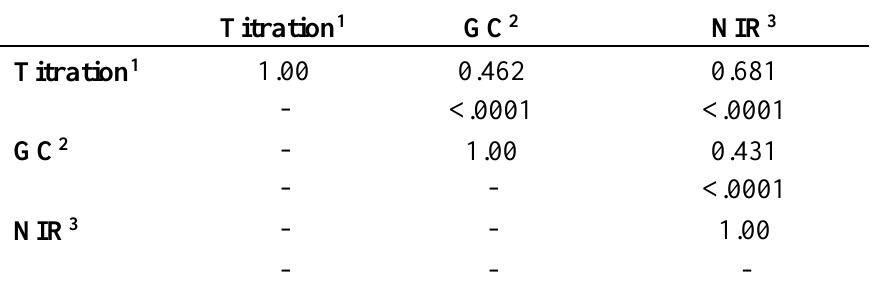
Table 9 . Pearson Correlation Coefficients and P-values for